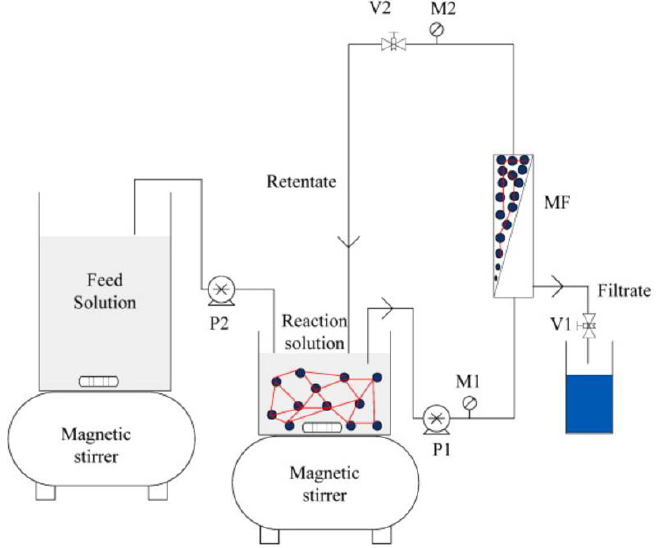
Figure 4. Schematic representation of the HBR experimental set-up. Reprinted from Ref. [128], with permission from Elsevier. License Number: 5394210088431.